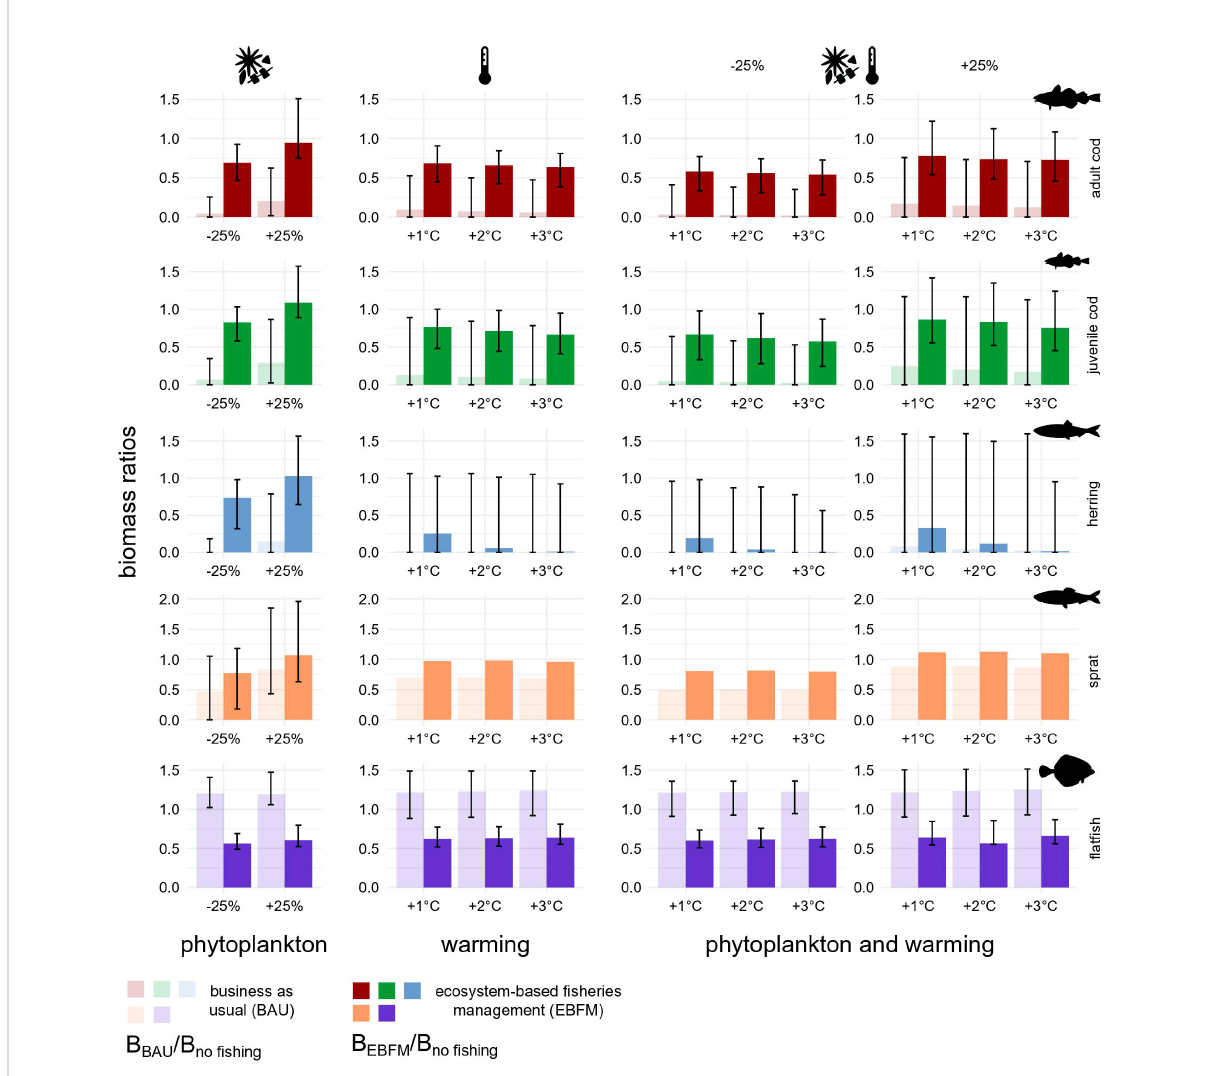
FIGURE 6 Biomass ratios under fi shing pressure plus phytoplankton biomass change, ocean warming, or all factors in combination. Each bar illustrates the ratio between the biomass under BAU (transparent) or EBFM (opaque) and the no- fi shing scenario biomass, all quanti fi ed using reference runs. Ratios equal to 0.5 indicate B MSY . Biomasses were computed as the average of values estimated for the last 20 years of each simulation (2081- 2100). Error bars were built using the corresponding Monte Carlo randomizations and show 2% and 98% percentiles as lower and upper bounds, respectively. Under all warming scenarios, sprat bar plots do not have error bars because its stock biomass was used as forcing